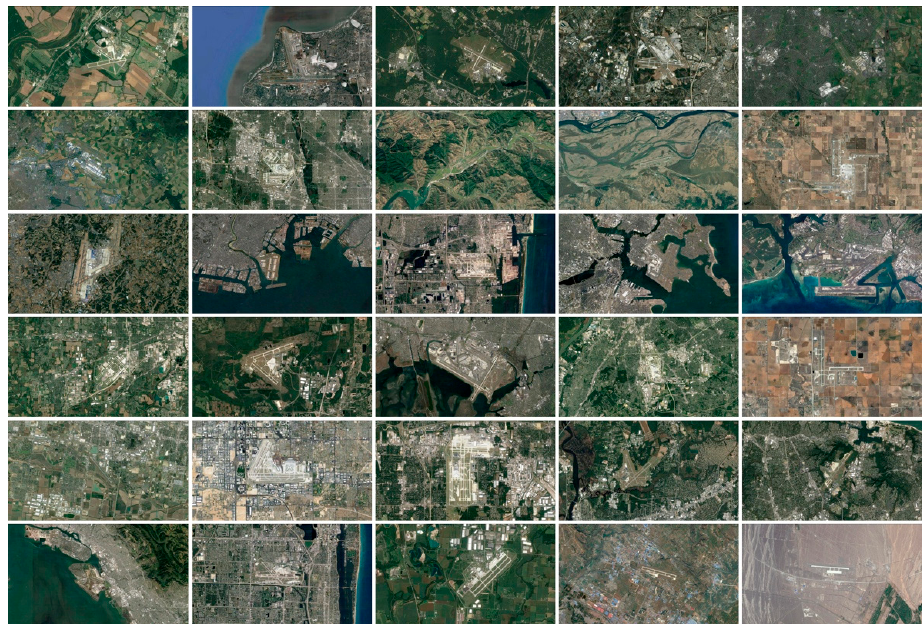
Figure 5. Some of the training airport images. [Image courtesy of Google Earth].